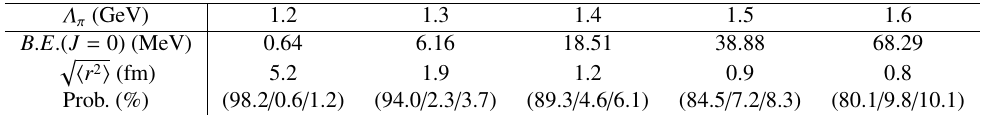
Table 3. Binding solutions for the J P = 0 + case with channel coupling in the OPEP model. The binding energies (B.E.) are given with relative to the Λ c N threshold. The probabilities correspond to Λ c N ( 1 S 0 ), Σ c N ( 1 S 0 ), and N ( 5 D 0 ), Σ ∗ c